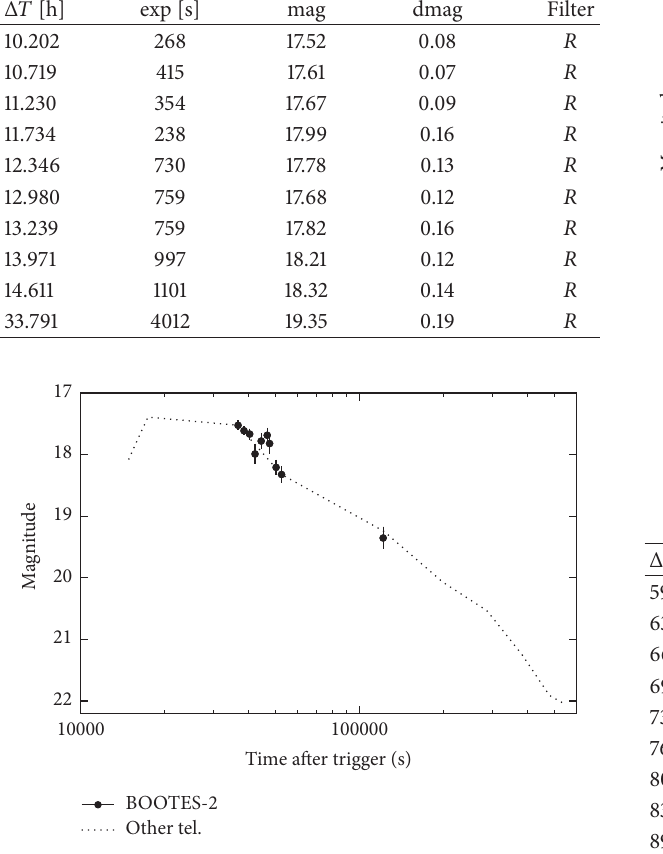
Figure 8: The optical light curve of GRB 100901A. The dotted line representing burst behaviour is based on observations by Gorbovskoy et al. [49], Kann et al. [51], and Rumyantsev et al. [52].